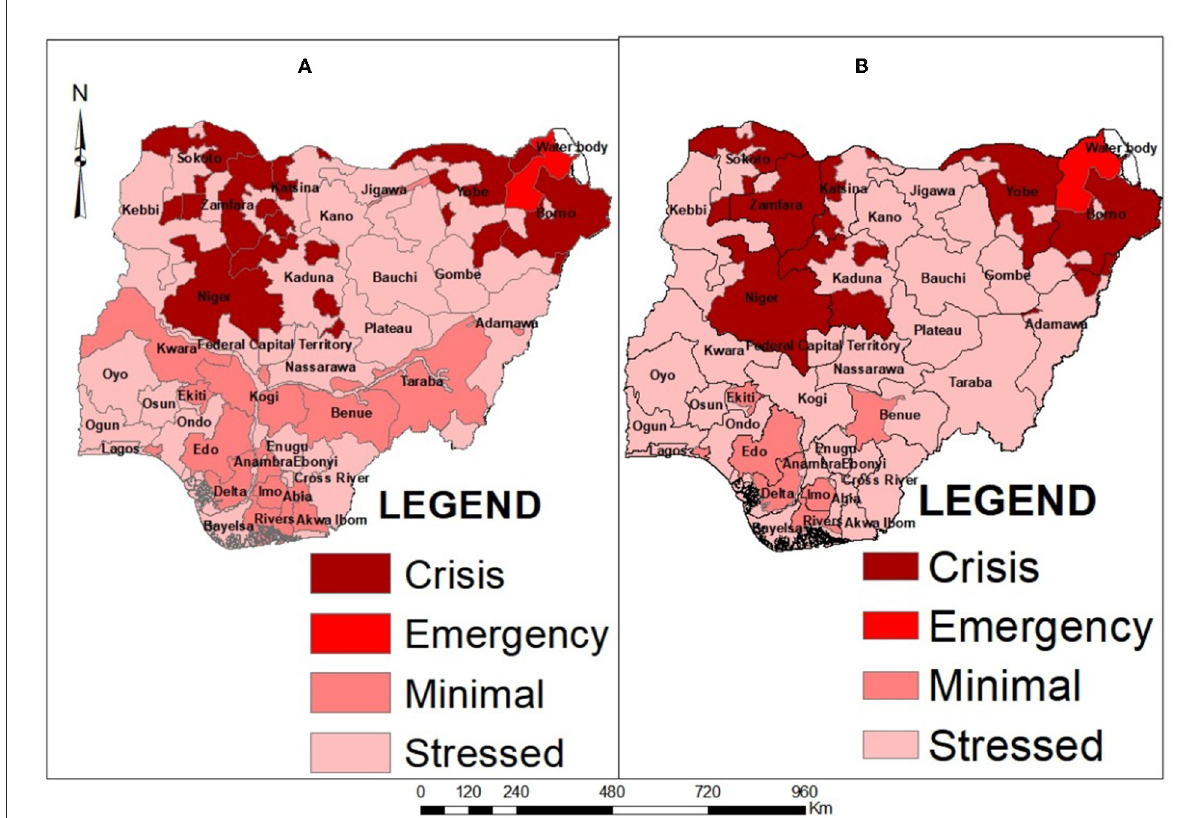
FIGURE4 Projected food insecurity prevalence in Nigeria. (A) March to May 2022. (B) June to September 2022. Source: Derived from FEWS NET, 2022.